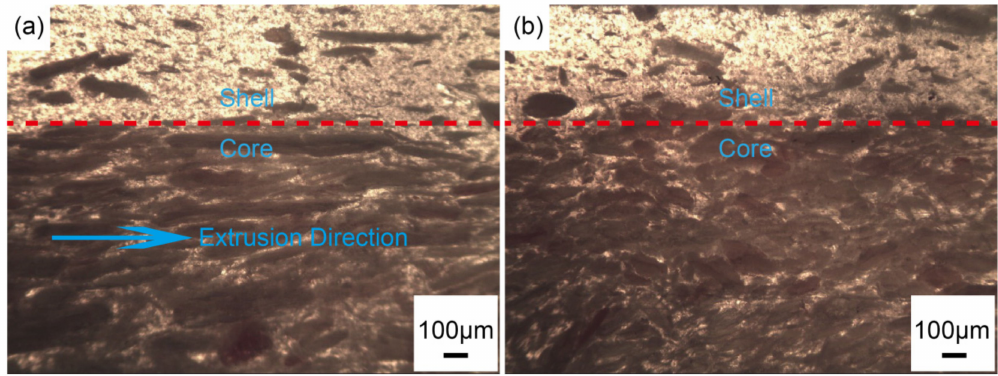
Figure 5. Optical micrographs of Co-WPCs (S0) along the extrusion direction (( a ) × 40) and in the cross-section transverse to the extrusion direction (( b ) ×